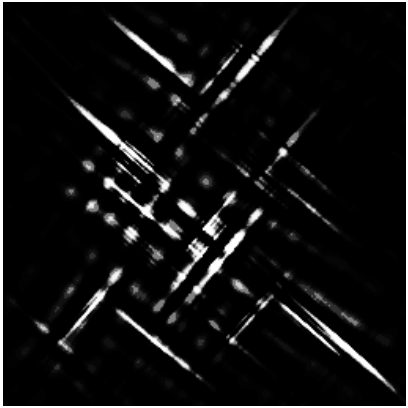
Figure 4. Image reconstruction using Curvelet coefficients of diagonal directions.